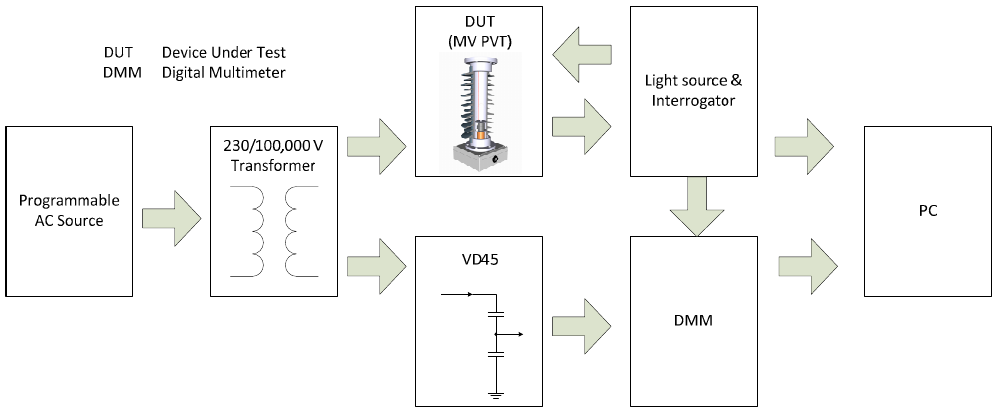
Figure 25. Experimental setup for MV voltage sensors calibration and testing.